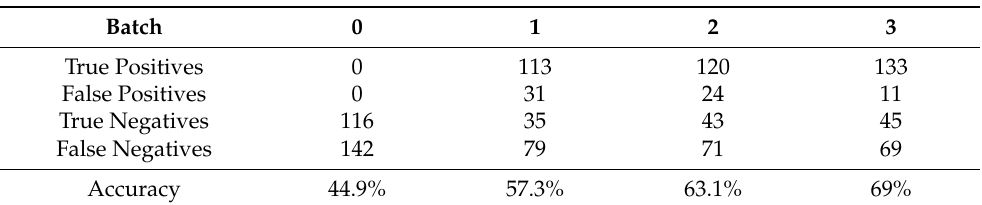
Table 5. Classifier’s accuracy without hyperparameters’ optimisation over training batches without the DIDComm